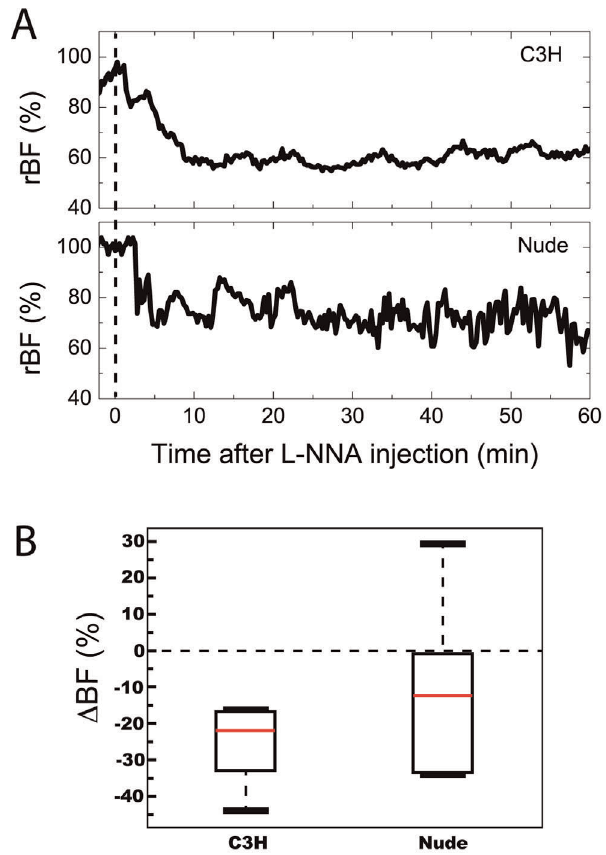
Figure 5. L-NNA decreases tumor blood flow in C3H animals. (A) Representative rBF time-courses in RIF tumors for a C3H and a nude mouse after L-NNA administration (represented by the dashed line at t=0 ). (B) Box plots of blood flow changes ( D BF) after L-NNA administration within animals of each strain (N=7 each); L-NNA decreased tumor rBF within C3H (p=0.016), but not within nude animals (p=0.16). As with previous experiments, nude animals displayed substantial heterogeneity in D BF.